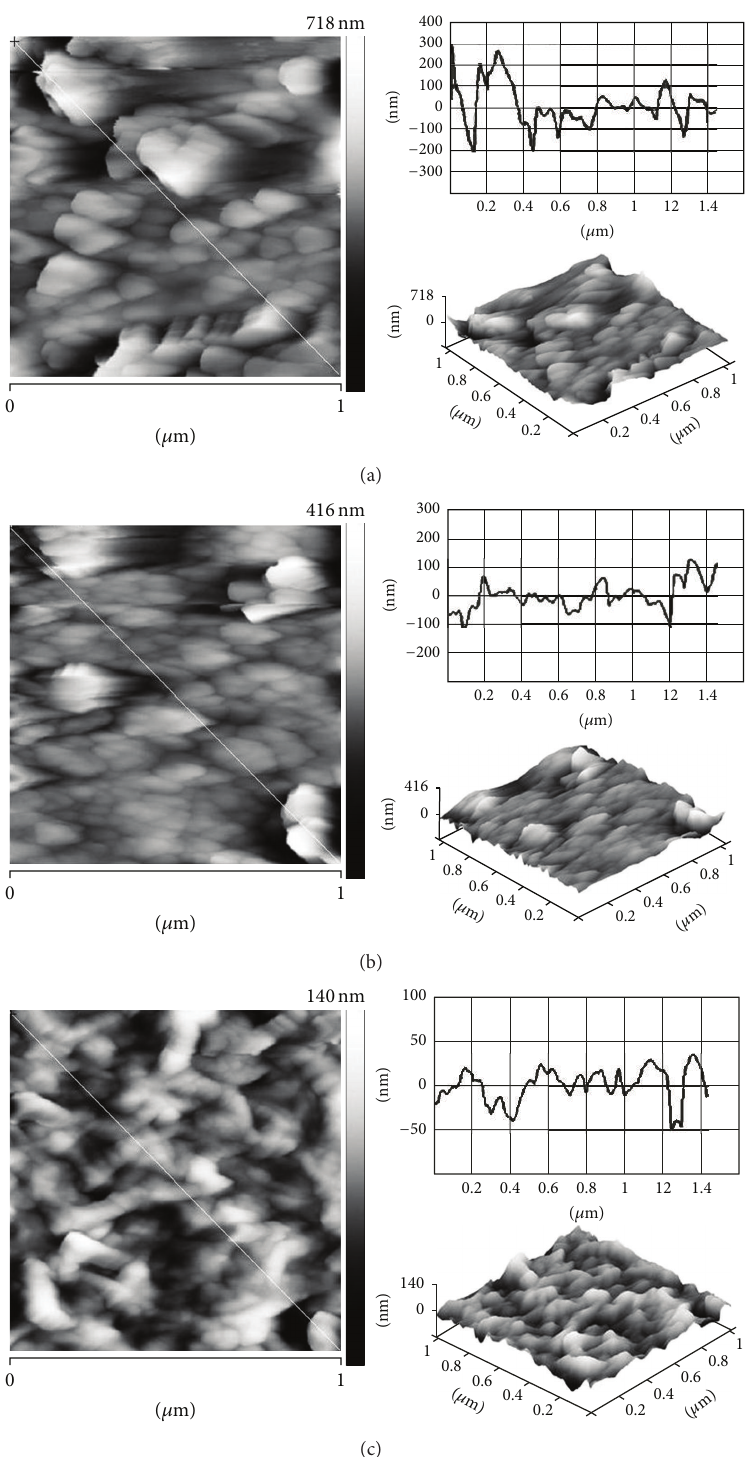
Figure 4: Two- and three-dimensionalAFM topographic images and one-dimensional line scans of electrodeposited Fe–Cu films grown from the electrolytes with low, intermediate, and high Fe ion concentrations (a) 0.02M (b) 0.04 M, and (c) 0.08 M,